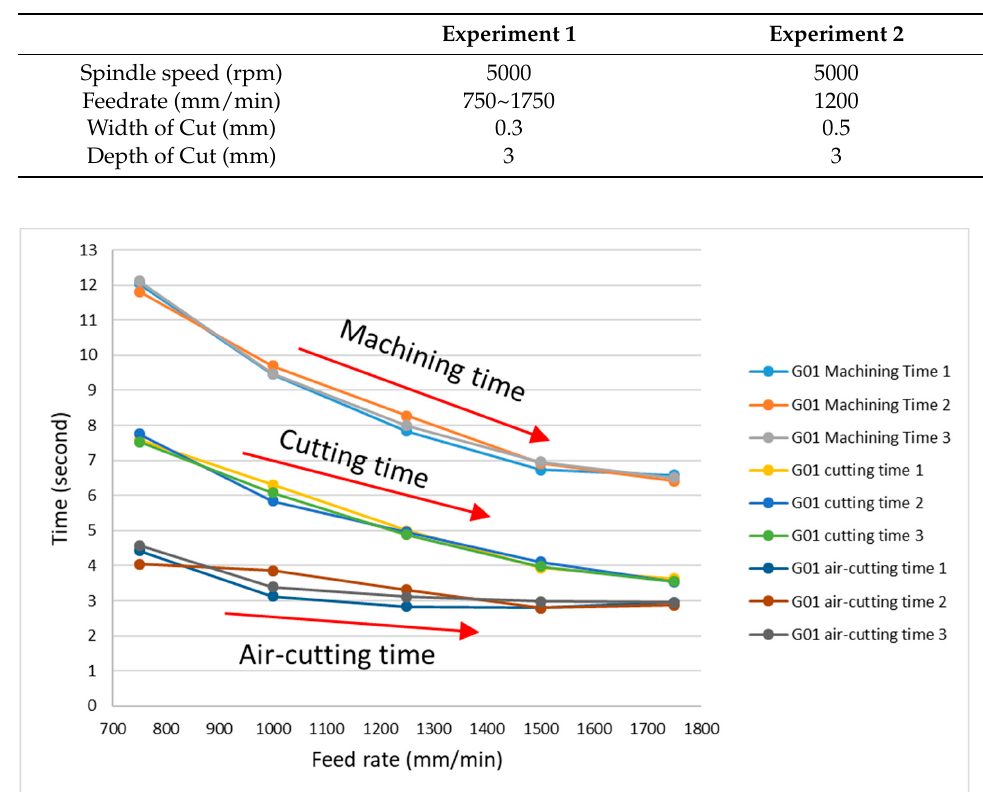
Figure 9. Results of verification experiment 1.